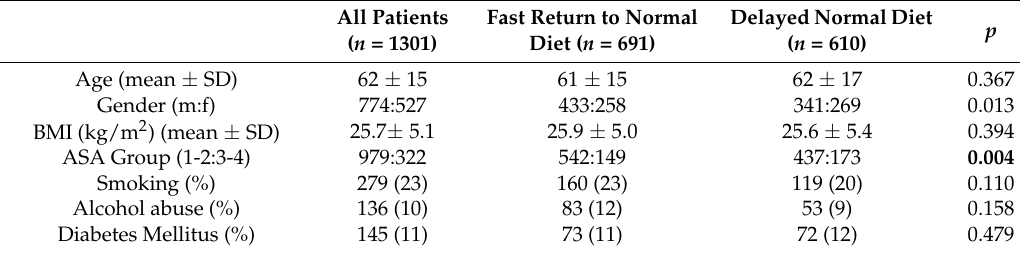
Table 1. Patients’